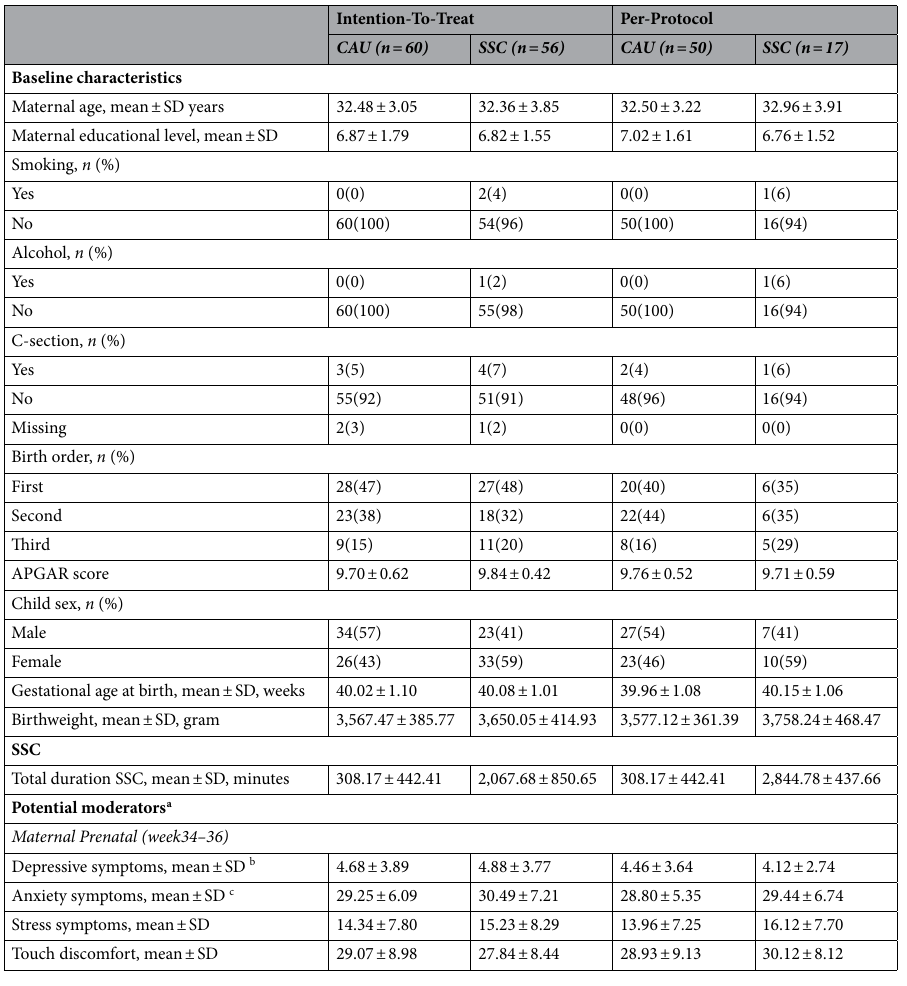
Table 1. Baseline characteristics and potential moderators of randomized participants. CAU care-as-usual, SSC skin-to-skin contact. a Winsorized data is presented for all moderator variables that included outliers. b A threshold of 10 indicates clinical levels of depression. c A threshold of 40 indicates clinical levels of